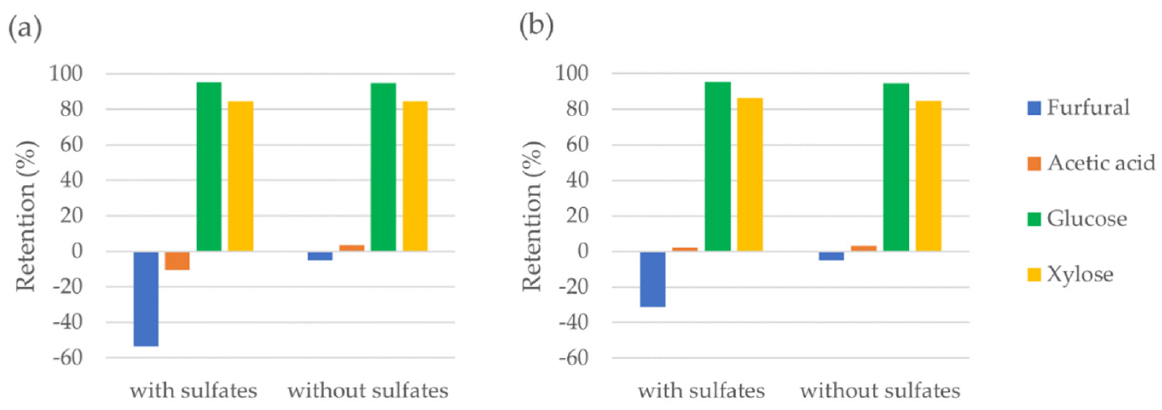
Figure 2. Effect of sulfates on the negative retention with ( a ) NF99HF and ( b ) NF270. As per Figure 2, the retentions of glucose and xylose were independent of the sulfates content in the stream. However, the effect of sulfates on the negative retentions of furfural and acetic acid can clearly be seen. Both NF99HF and NF270 showed more negative retentions with sulfates than without sulfates in the stream. This result showed that the presence of sulfates enhances negative retention of acetic acid and furfural possibly due to the intermolecular interactions in the feed occurring by sulfates. It can be explained as follows, the presence of sulfates having high retention induces an increased passage of acetic acid and furfural through the membrane due to the increased electric potential. The study of Schlackl et al. [17] suggests a similar explanation for the observed phenomena. This effect could be studied in more detail by changing the concentration of sulfates and with the presence of other